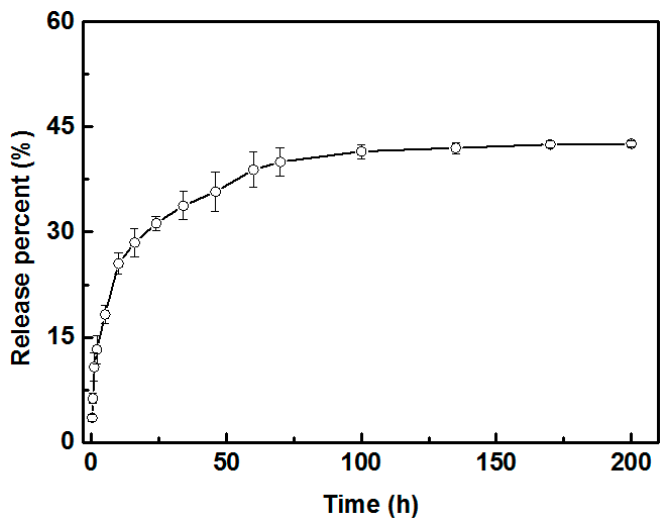
Figure 4. In vitro release curve of cellular capsule deriving Pickering emulsion marbles.